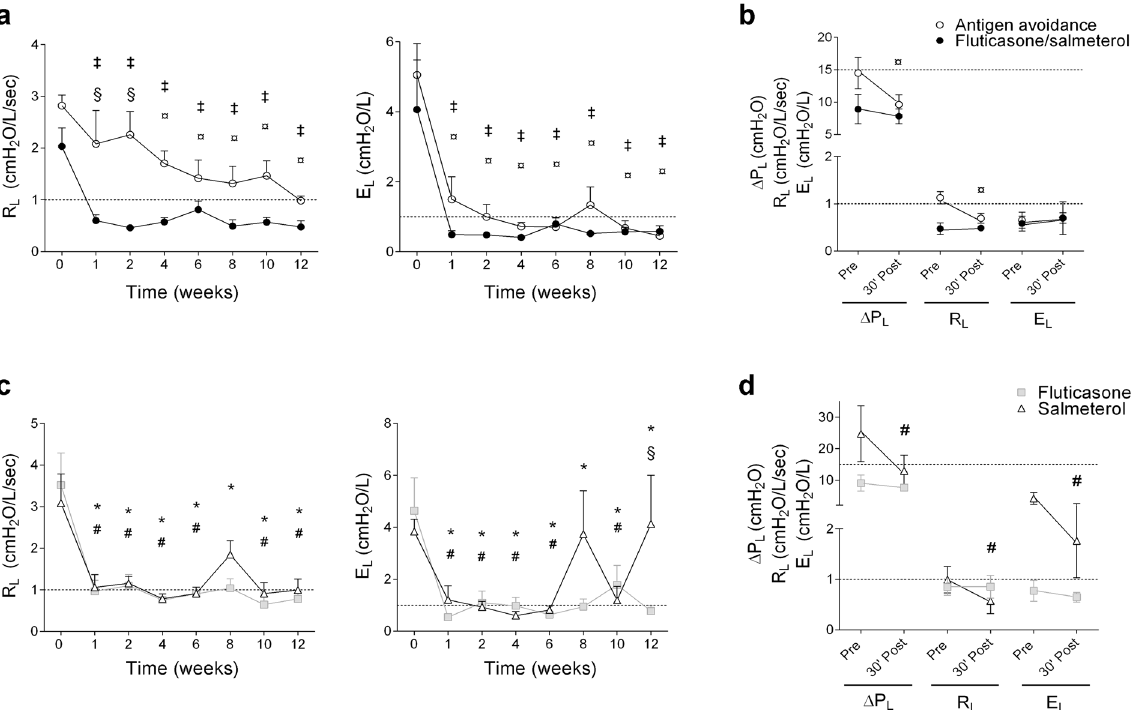
Figure 1. Pulmonary function and bronchoreversibility tests performed in study I ( a,b ) and II ( c,d ). Bronchodilator response was evaluated before and 30 minutes after the administration of inhaled albuterol 500 μ g ( b ) or intravenous N-butyl-scopolamine 0.03 mg/kg ( d ) to detect residual airway obstruction. Values are expressed as means ± S.E.M. Dashed lines represent normal threshold in healthy horses. R L : pulmonary resistance; E L : pulmonary elastance; Δ P L : swing in transpulmonary pressure. ‡different from baseline of the same group for fluticasone/salmeterol (p < 0.0001), ¤different from baseline for antigen avoidance (p < 0.05), * different from baseline for fluticasone (p < 0.0001), #different from baseline for salmeterol (p < 0.0001), §difference between groups at the time point indicated (p <